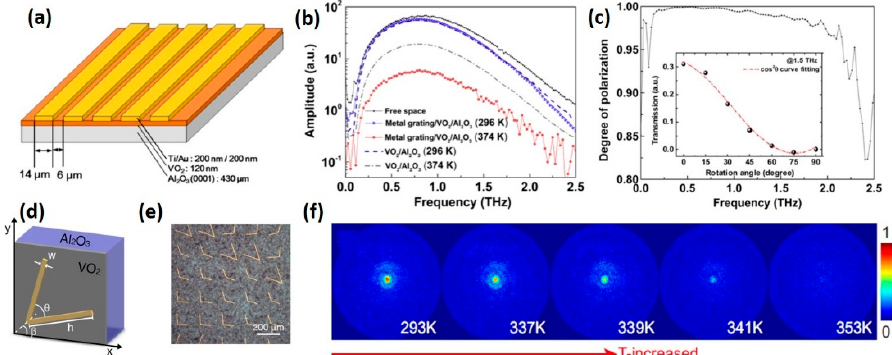
Figure 11. Tuneable metamaterials consisting of VO 2 film and metal meta-atoms. ( a ) Schematic of the switchable linear polarizer: Au/Ti metallic gratings deposited on VO 2 /c-sapphire. Metal gating width: Free space = 14 μ m:6 μ m. ( b ) Frequency responses of the metal-grating hybrid film and bare film in 0–2.5 THz range at 296 K and 374 K. ( c ) The degree of polarization. Inset: Polarizer angle rotation dependence of wave intensity at 1.5 THz (dot line) and cos 2 ( θ ) term fitting curve (red dash-dot line). Reproduced from [142], with permission from Institute of Physics 2015. ( d ) Schematic of the tuneable metamaterial lens: View of a single V-shaped antenna unit. ( e ) SEM image of the partial metamaterial. ( f ) The evolution of the amplitude distribution on the focal plane in the heating process. Reproduced from [143], with permission from Springer Nature 2016.